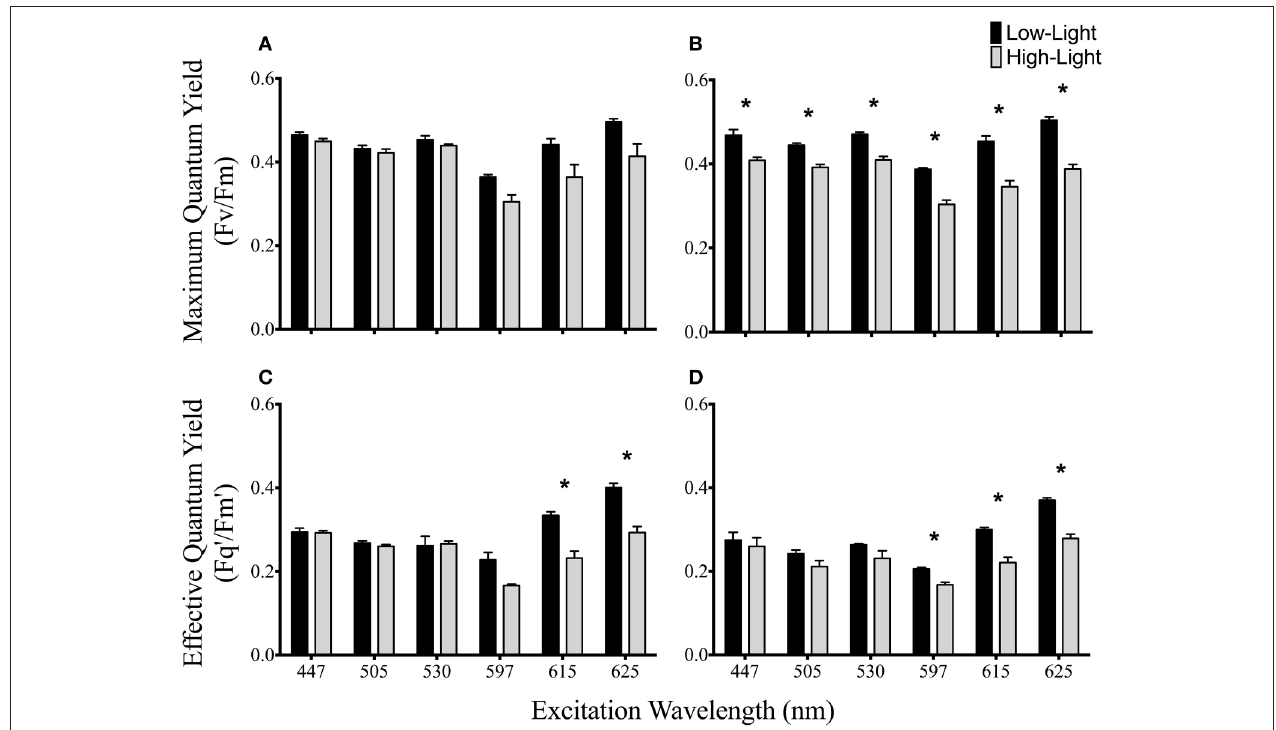
FIGURE 3 | Spectrally dependent maximum and effective quantum yields of PSII photochemistry in anemones photoacclimated to two light levels. Maximum quantum yields for high and low light acclimated (A) A4-a and (B) B1-a symbiont strains. High and low light acclimated effective quantum yields for (C) A4-a and (D) B1-a symbiont types. Dark bars represent low-light and gray bars represent high-light acclimated anemones. Error bars represent ± SE. Asterisks represent significant differences between low and high light conditions.